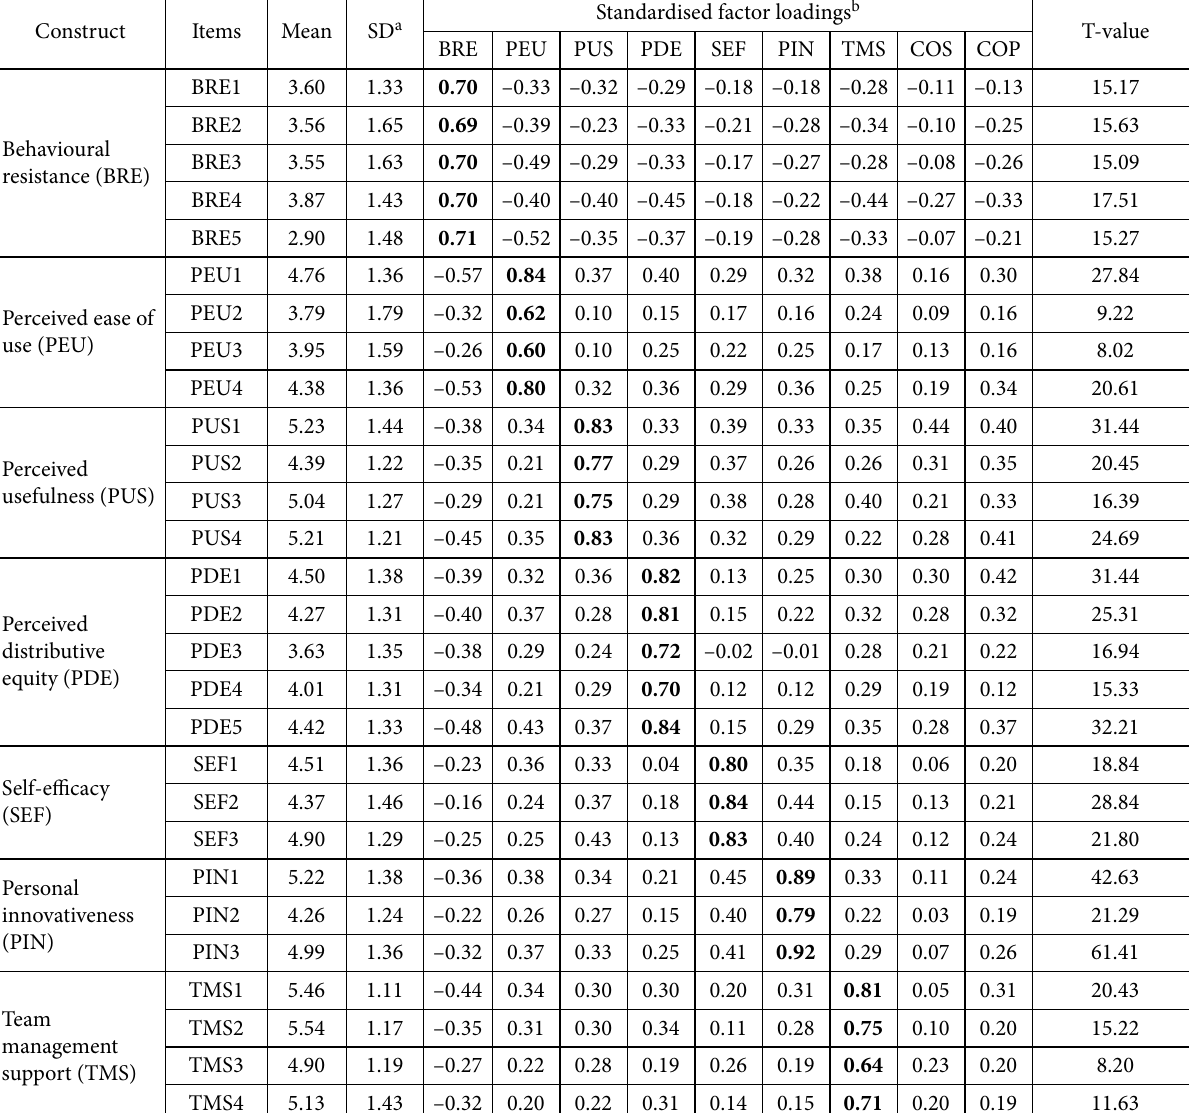
Table 4. Factor loadings for multi-item